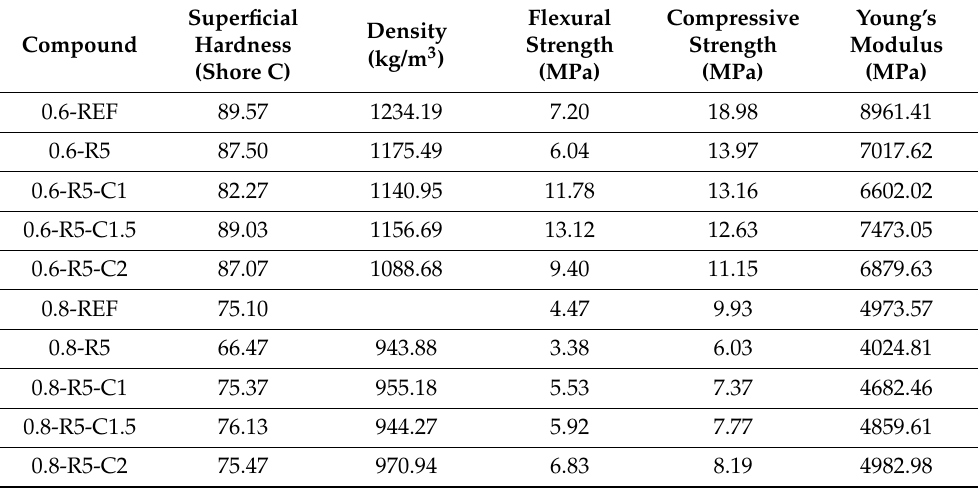
Table 6. Shore C hardness, density, flexural strength, compressive strength and dynamic moduli of elasticity results for the different series analyzed.